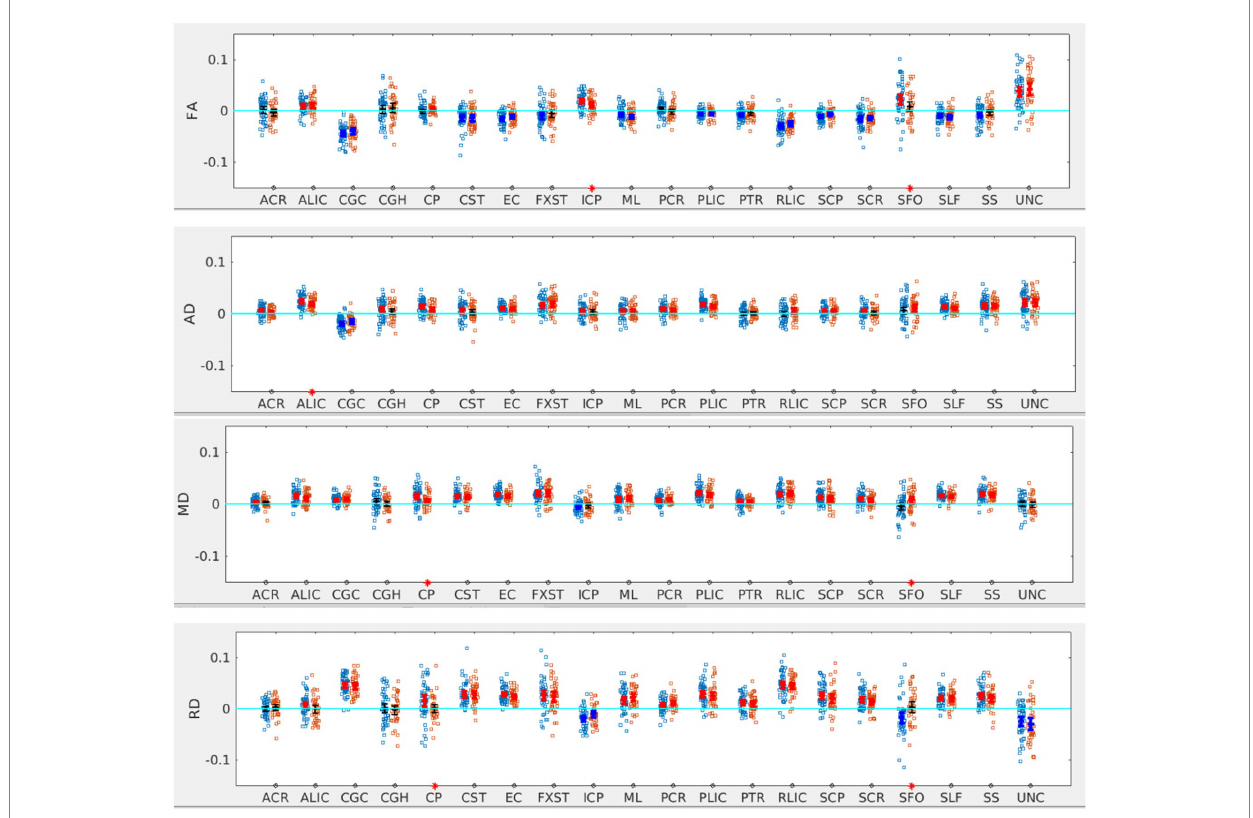
FIGURE 3 LI plotted for each of the 87 participants for the 20 bilateral tracks for DTI metrics comparing SOR (blue dots) to non-SOR (red dots) means with 95% CI are resented in the figure for SOR and Non SOR, 95% CI bars in red represents significant right lateralization (positive LI) of the tract while blue bar represents significant left lateralizatin (negative LI) of the tract. Red asterisks on the X axis represent tracts for which difference between SOR vs. non SOR was significant at p <